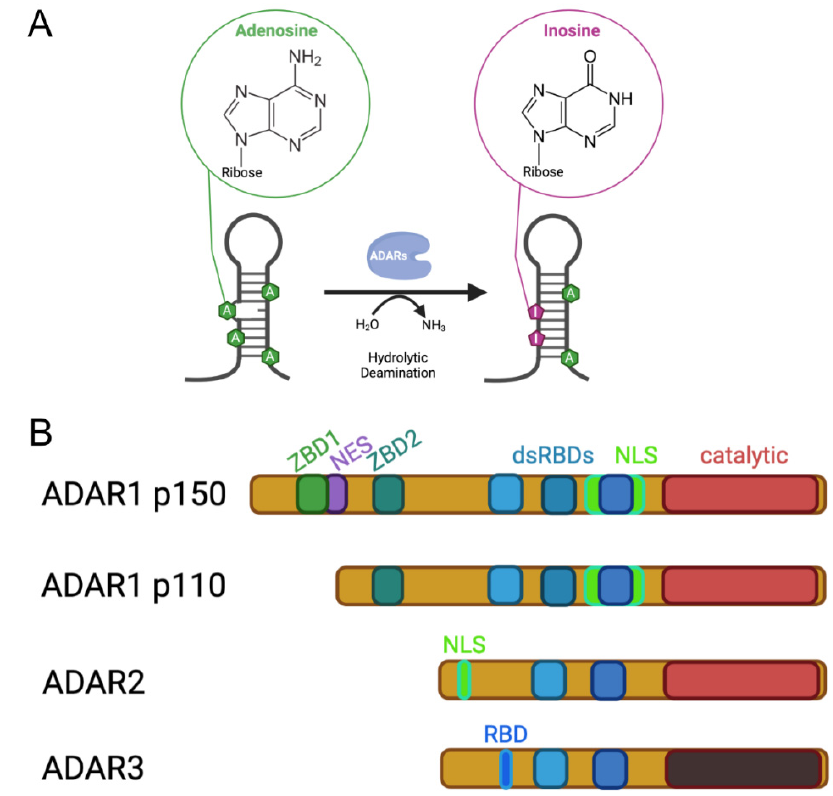
Figure 1. Activity and architecture of mammalian ADARs. ( A ) Adenosine deaminases acting on RNA convert adenosines via hydrolytic deamination to inosines. ( B ) Three ADAR genes can be found in mammals, ADAR1, ADAR2 and ADAR3. ADAR1 is expressed in two isoforms, ADAR1 p150 of 150 kDa, which is expressed from an interferon-inducible promoter, and ADAR1 p110, which is constitutively expressed. All ADARs contain a deaminase domain at their C-terminus. However, the catalytic domain of ADAR3 is enzymatically inactive. Substrate engagement of the ADARs is mediated via a variable number of double-stranded RNA-binding domains (dsRBDs) that interact with structured and double-stranded RNAs. The amino termini of the ADAR proteins are quite divergent. While the N-terminus of ADAR1 harbors a Z-DNA binding domain (ZBD) that is able to interact with Z-DNA and ZRNA, the long N terminus of ADAR1 p150 also harbors a nuclear export signal (NES), resulting in mostly cytoplasmic localization of this interferon-induced isoform. A nuclear localization signal (NLS) that overlaps the third dsRBD of ADAR1 is negatively regulated by RNA binding. As a consequence, the p150 isoform of ADAR1 can shuttle between the nucleus and cytoplasm. The N-terminus of ADAR2 harbors its classical nuclear localization signal. The catalytically inactive ADAR3 protein contains an N-terminally located RNA-binding domain (RBD).